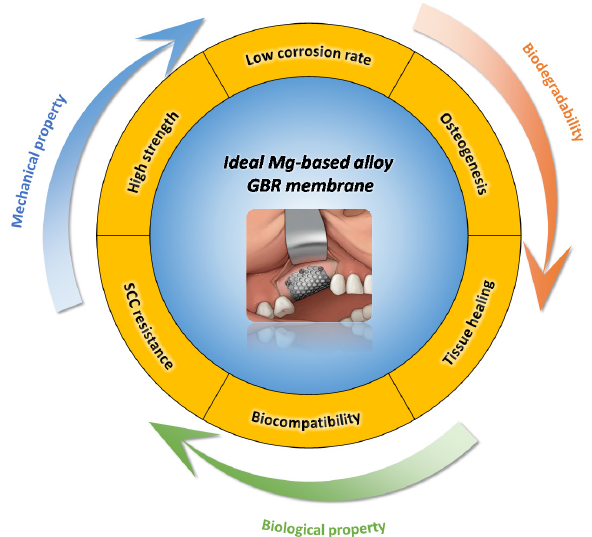
Figure 12. A schematic diagram showing the required characteristics of ideal Mg-based alloy GBR membranes.